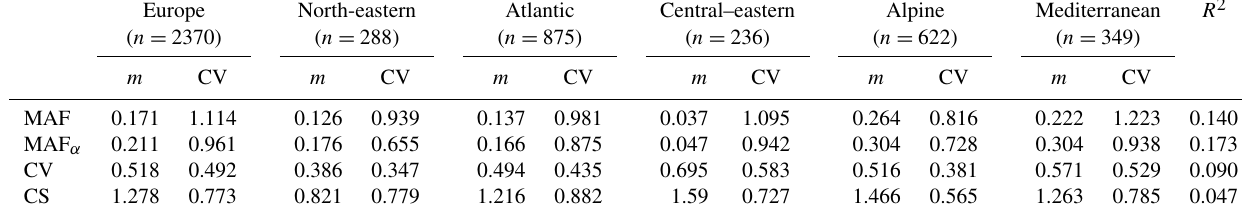
Table 2. Regional mean ( m ) and regional CV of the mean annual specific flood (MAF, m 3 s − 1 km − 2 ), mean annual specific flood normalized